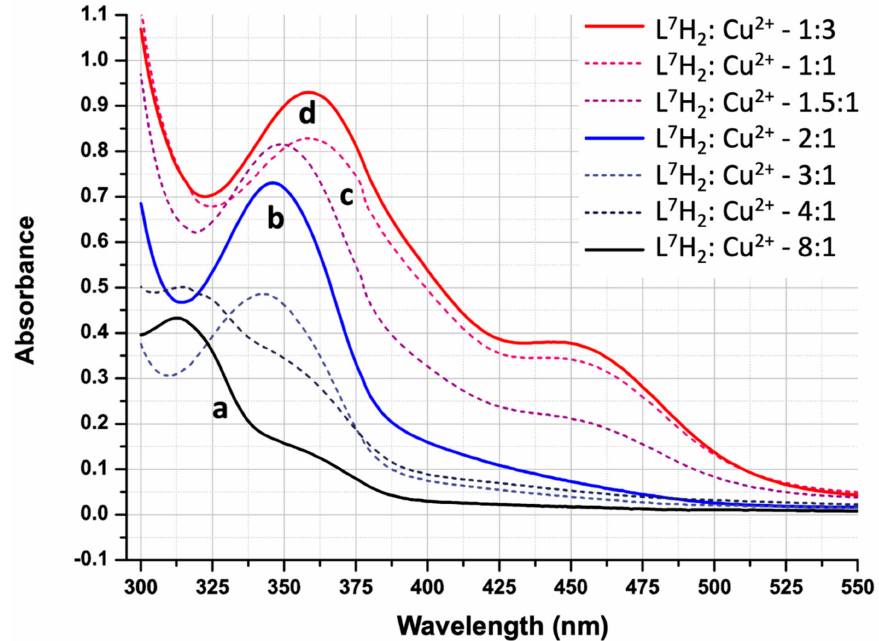
Figure 10. UV/Vis spectra of 80 µ M solutions of L 7 H 2 in MeCN containing varying concentrations of Cu(OAc) 2 .H 2 O ( L 7 H 2 to Cu 2+ molar ratio ranging from 1:3 to 8:1). The proligand has an absorption maximum at 313 nm and a shoulder around 360